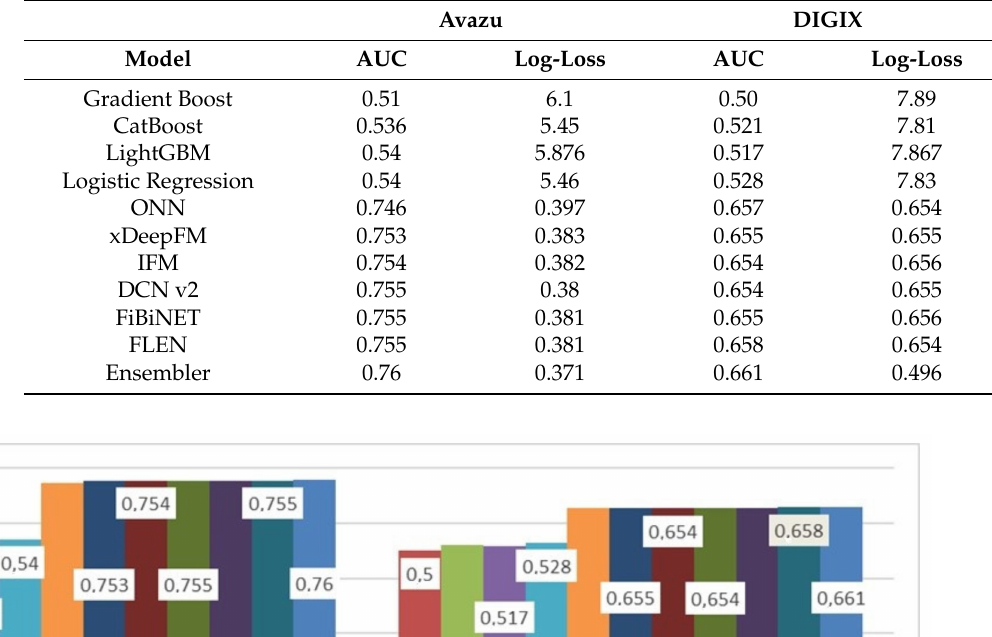
Table 1. Model performances for the Avazu and Digix dataset.